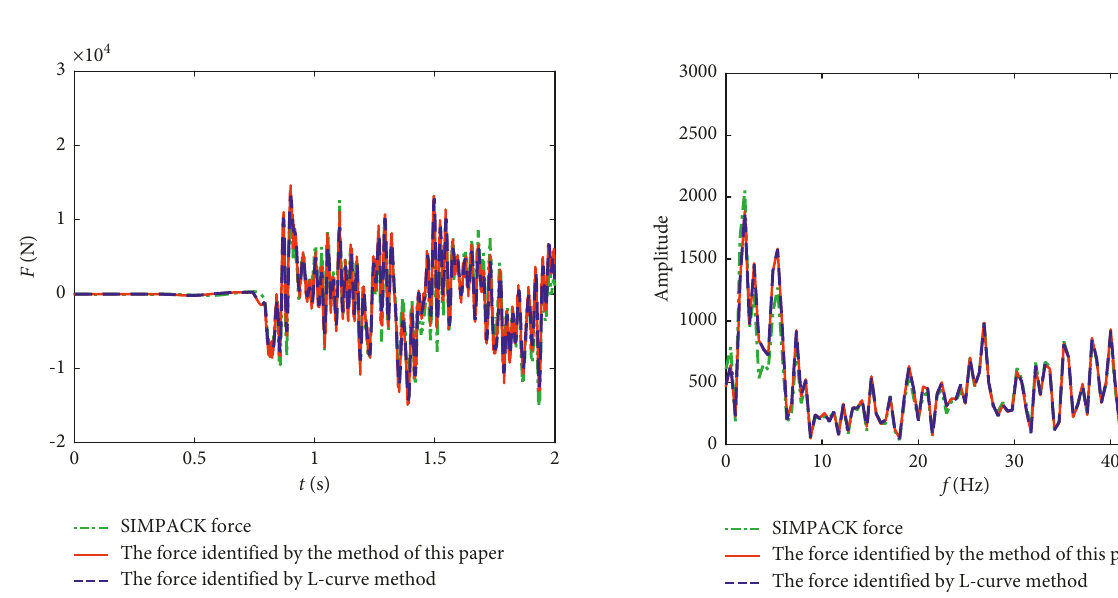
Figure 18: Load time-history diagram of the two methods for F identification when the noise level is 0%.